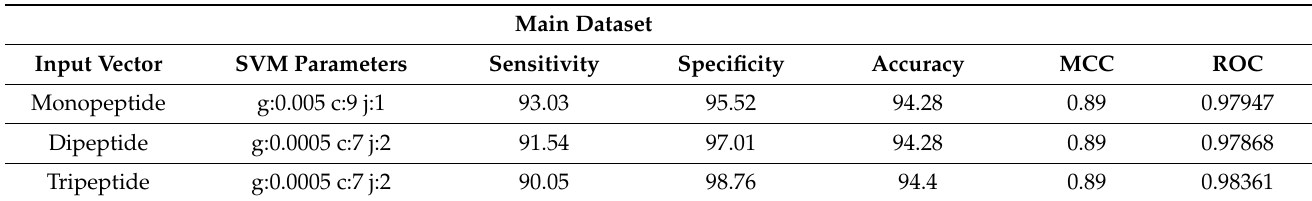
Table 1. Performances of SVM models developed using mono-, di-, and tripeptide acid composition of peptides using five-fold cross-validation.